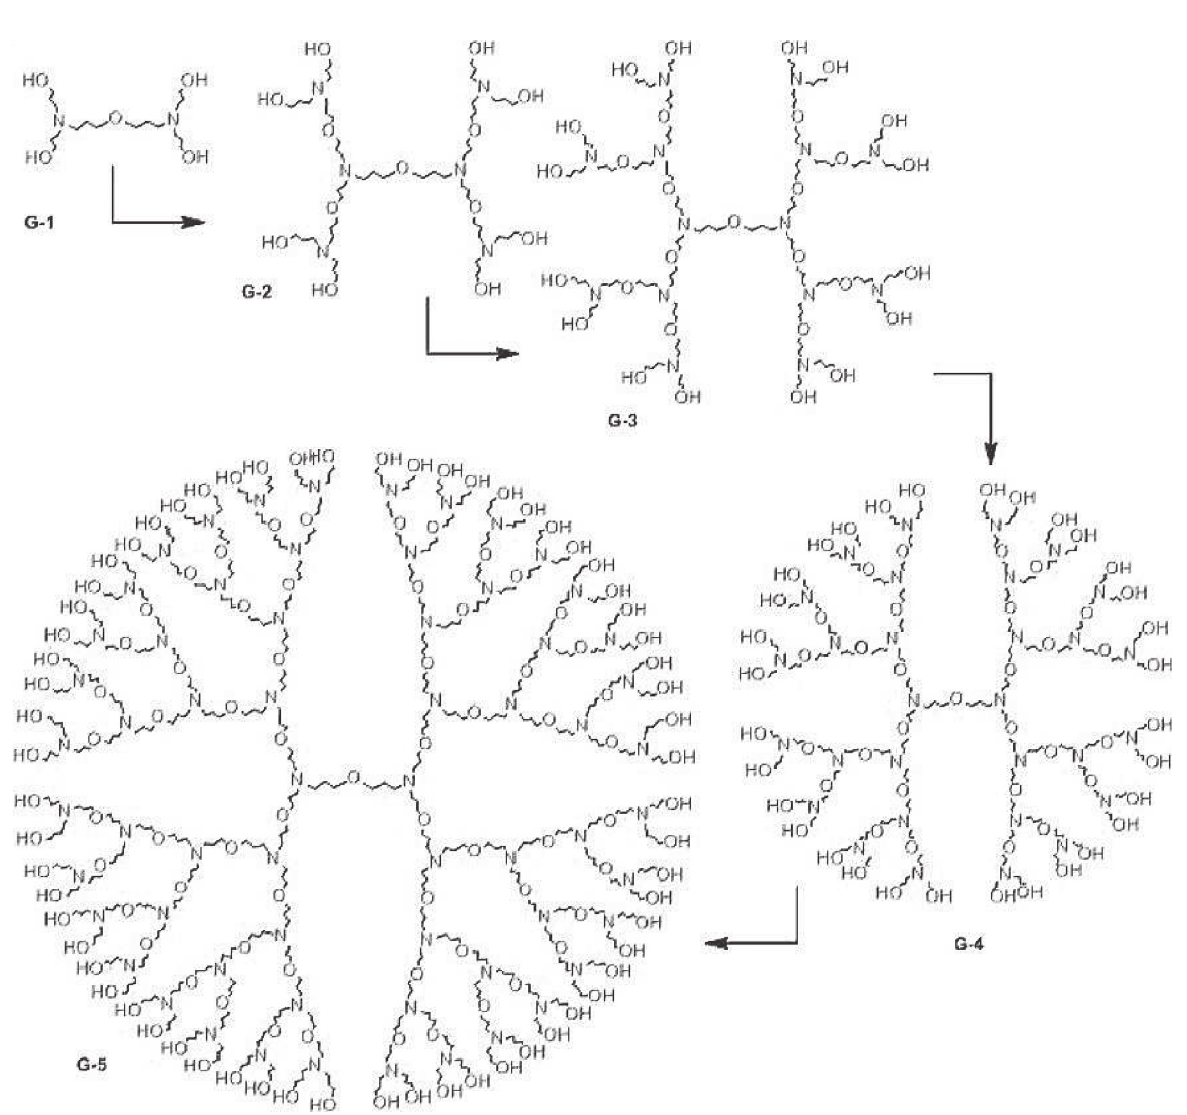
Figure 1: Chemical structural formula of PPEI